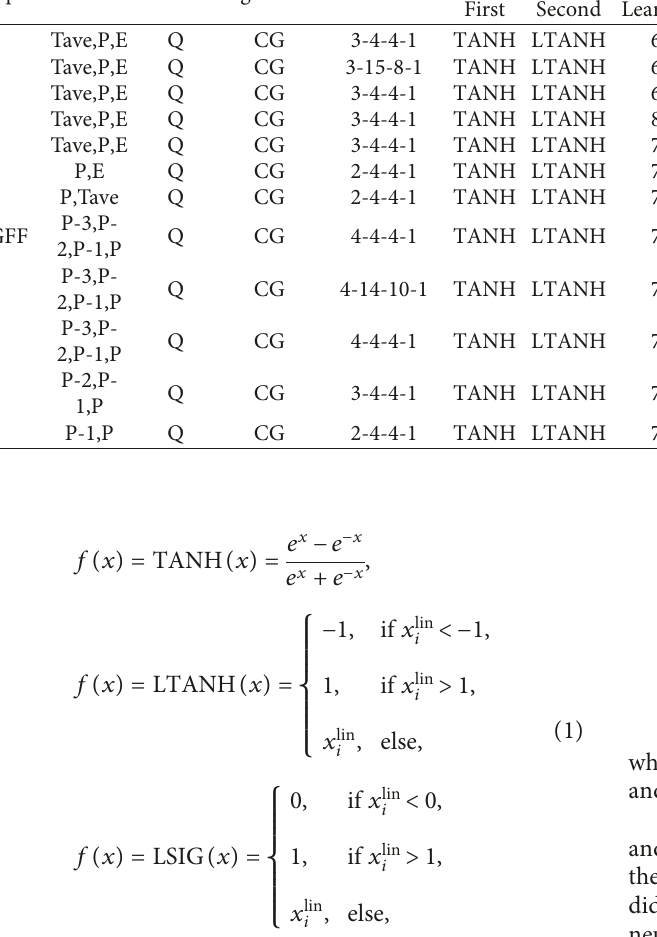
Figure 12: Comparison of the average annual observational value and the three future periods under three emission scenarios. Table 8: Performances of different neural networks concerning the monthly rainfall-runoff model for the Doroudzan catchment.